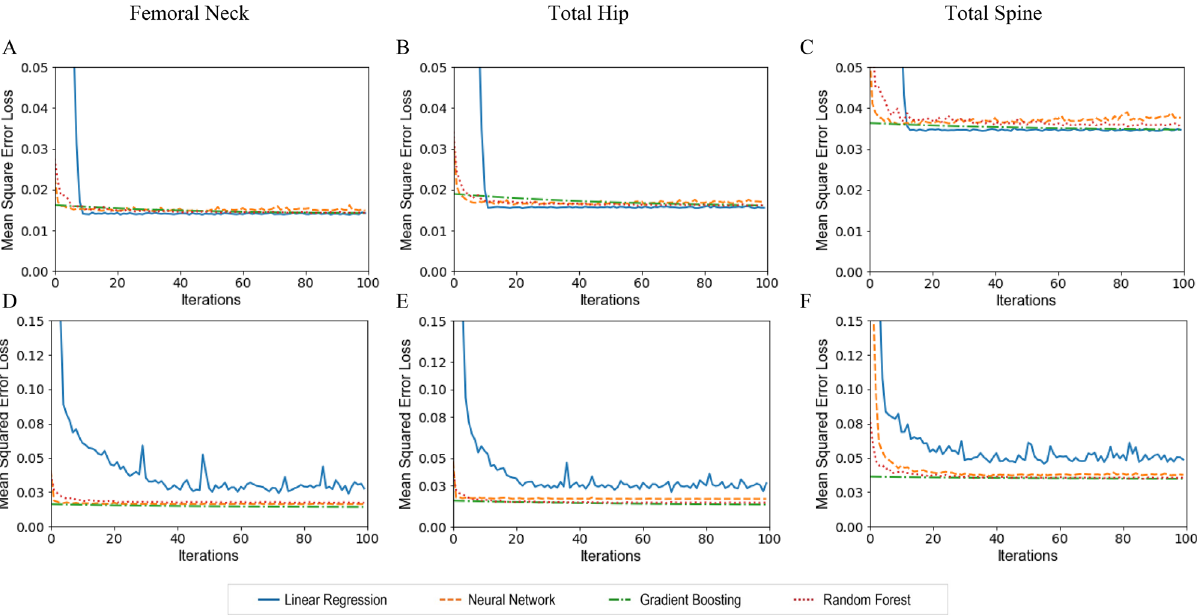
Figure 3. Mean squared error loss of various models with the number of training iterations for BMD prediction in the test dataset ( n = 1026 ) . The upper panel shows the performance of each model with phenotype covariates and GRS as predictors in predicting BMD at the femoral neck ( A ), total hip ( B ), and total spine ( C ) in the testing dataset at different BMD sites. The lower panel shows the performance of each model with phenotype covariates and 1103 individual SNPs in predicting BMD at the femoral neck ( D ), total hip ( E ), and total spine ( F ). Lasso regularization with the penalized value of 0.01 was used in the linear regression model for 1103 individual SNPs and phenotype